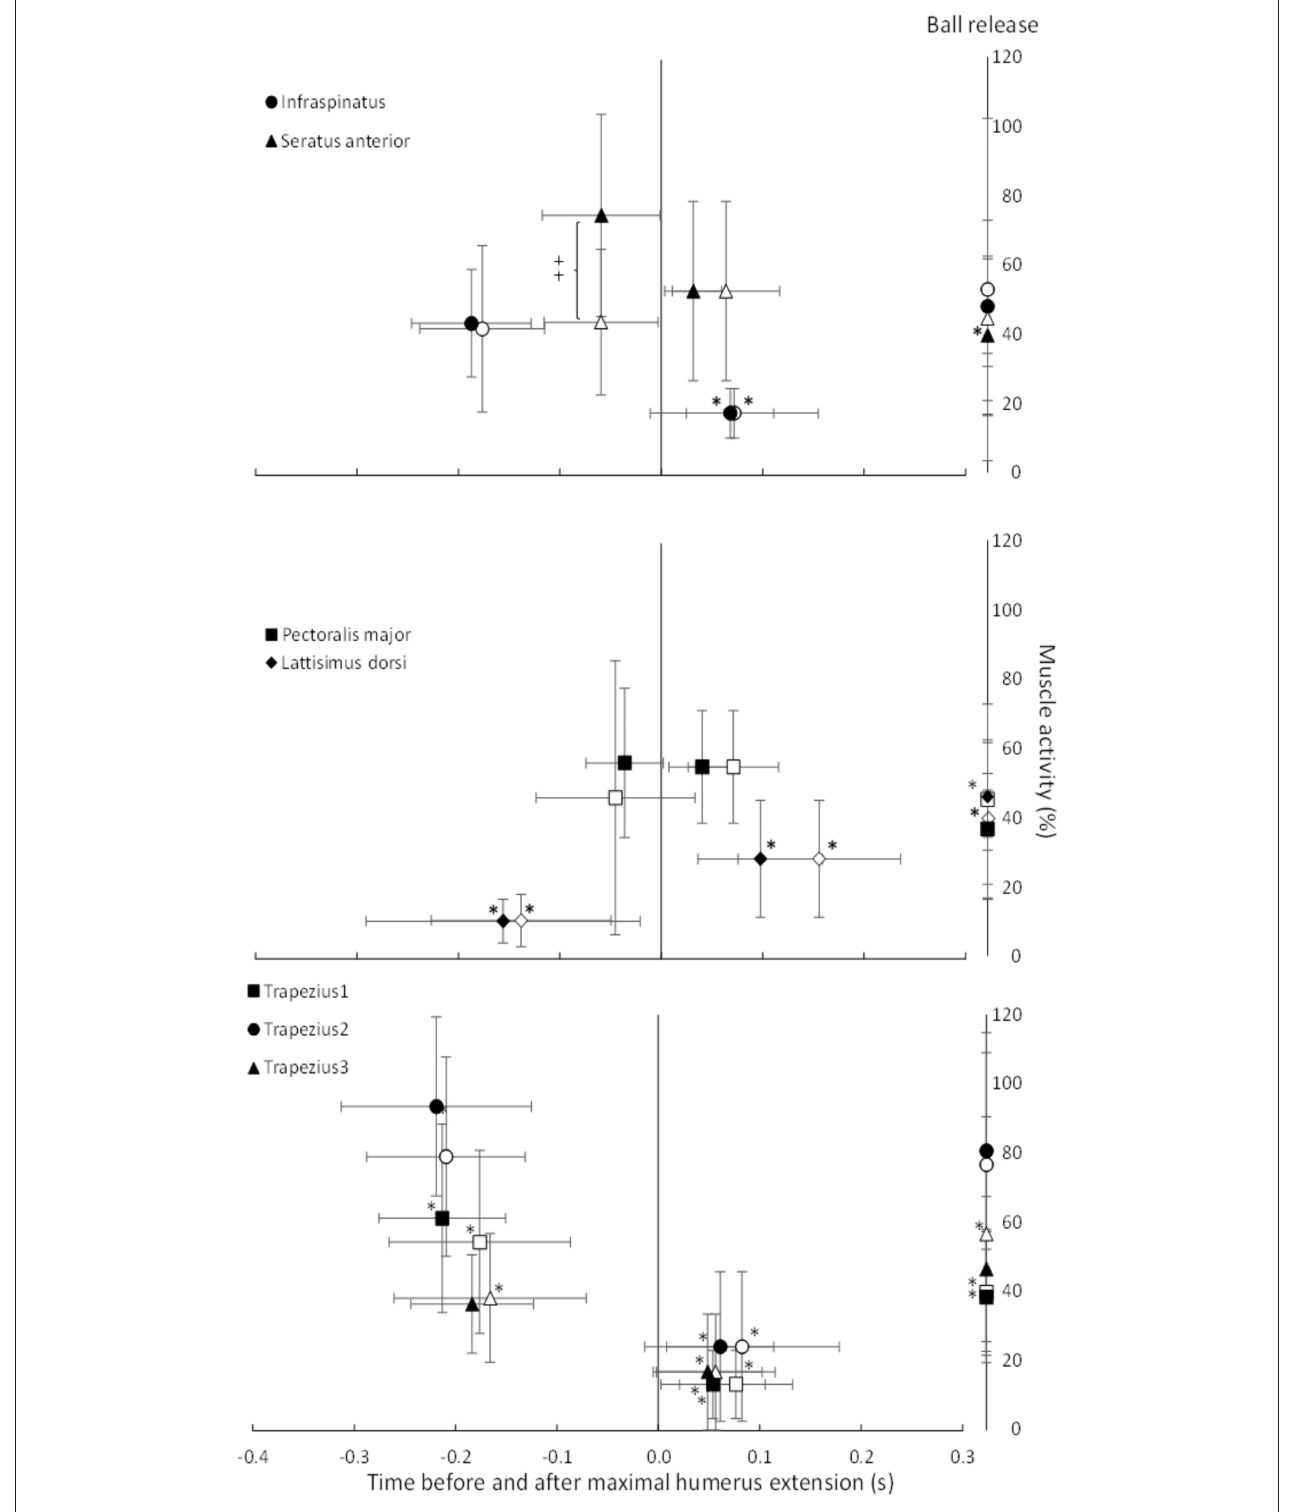
FIGURE 6 | Average ( ± SD) peak EMG activity and timing per muscle before and after maximal shoulder extension (0.0) and at ball release per group (pain group: open symbols, no pain group: closed symbols). *Indicates a significant difference in peak EMG activity for this muscle for this group at this event compared with the two other events. ‡ Indicates a significant different between the groups for this peak EMG activity on a p ≤ 0.05 level.